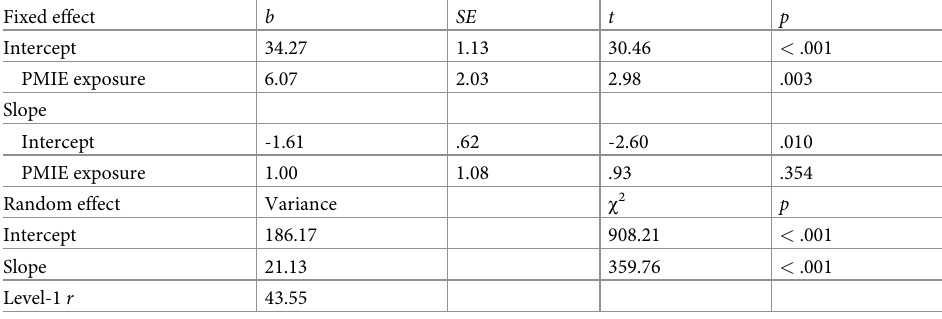
Table 4. Hierarchical linear model of the role of perceived betrayal on psychosocial functioning over the course of 10 months among healthcare providers during the COVID-19 pandemic.